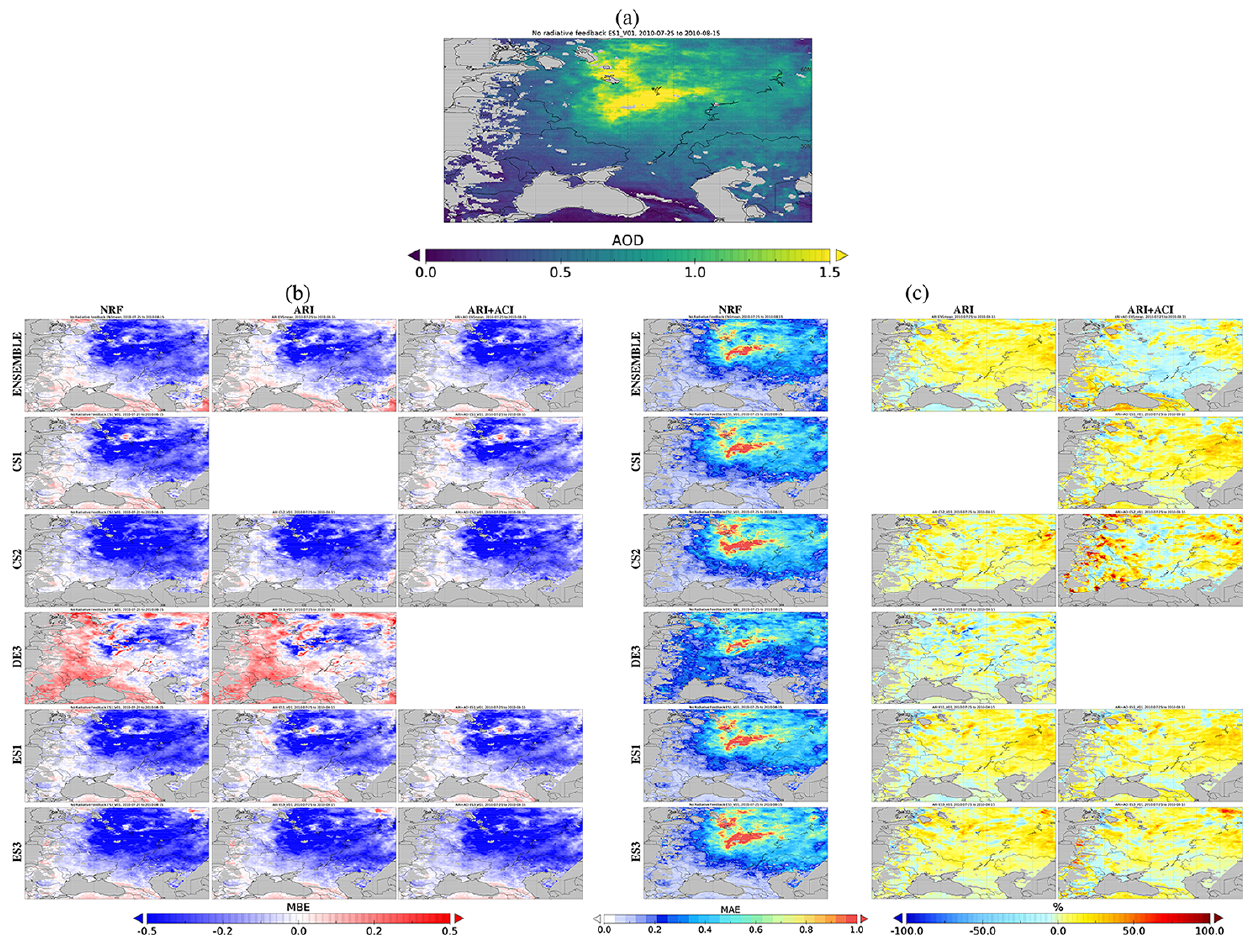
Figure 2. Model-MODIS comparison of AOD at 550nm for the Russian wildfires case: (a) satellite values; (b) MBE for NRF (first column), ARI (second) and ARI + ACI (third); and (c) MAE for the NRF simulations (first column) and their improvements due to ARI (second) and ARI + ACI